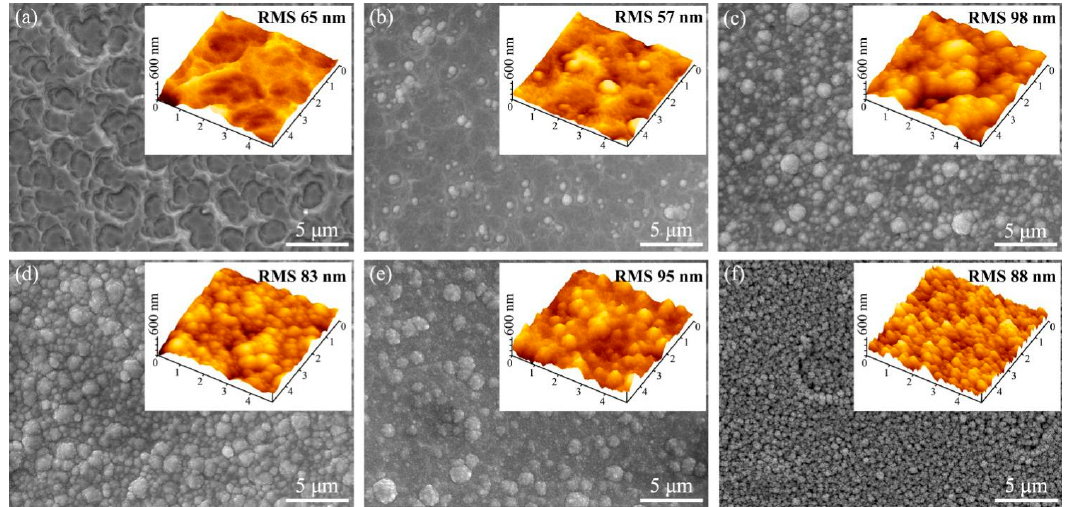
Figure 3. SEM and AFM images of the hafnium carbide-silicon carbide (HfC-SiC) mixed bi-interlayers deposited with different TMS flow rate increment: (a) 0.10 sccm/2 min, (b) 0.15 sccm/2 min, (c) 0.20 sccm/2 min, ( d) 0.25 sccm/2 min, (e) 0.30 sccm/2 min, (f) 0.35 sccm/2 min.